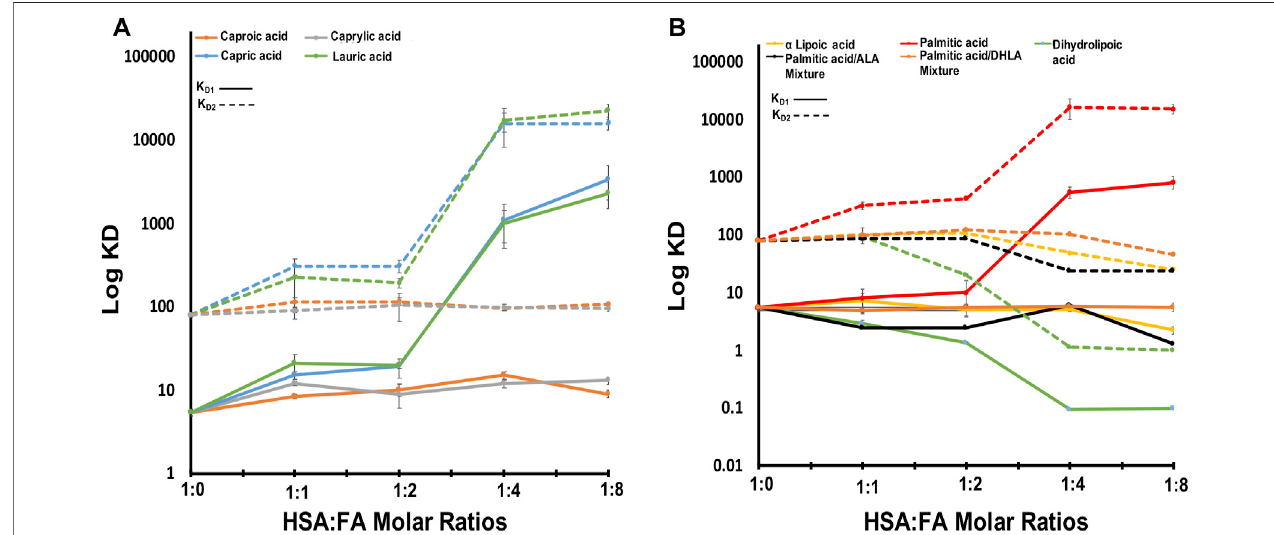
FIGURE2| The obtainedKD1,2ofHSA-FAs complexes comparedtofreeHSA. (A) TheKD valuesofHSA incomplexwithcaproic acid, capric acid,caprylic acid, andlauricacid. (B) TheKDvaluesofHSAincomplexwith α lipoicacid,palmiticacid,dihydrolipicacid,palmiticand α lipoicacidmixture,andpalmiticanddihydrolipicacid mixture. KD1 is indicated with solid lines and KD2 is indicated with dotted lines. Error bars represent standard deviation (SD).